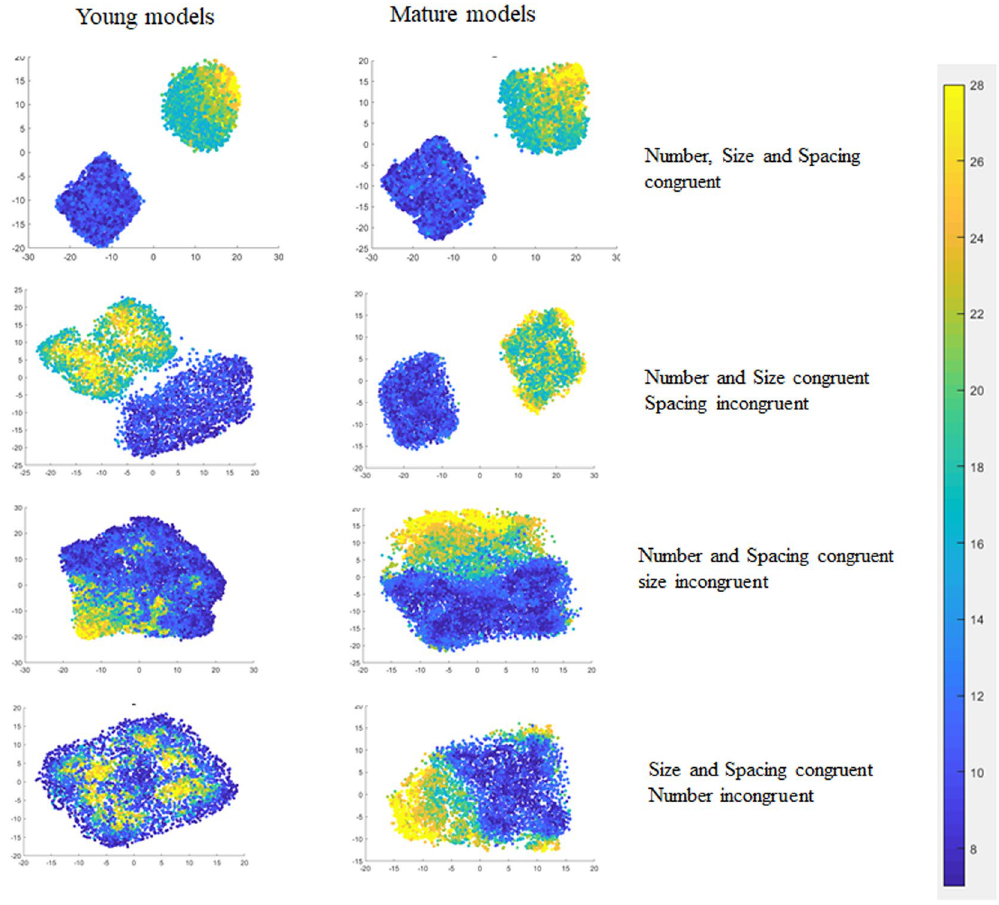
Figure 5. Manifold projection using t-SNE. Stimuli with a small or large numerosity (respectively in the ranges 7:12 and 16:28) were first selected from the complete image data set. In the top panels, Numerosity, Size and Spacing are all congruent, which means that images with a small number of dots also have low Spacing and Size values. In the second-row panels, Numerosity and Size are congruent, but Spacing is not. In the third-row panels, Numerosity and Spacing are congruent, but Size is not. In the bottom panels, both Spacing and Size are incongruent with Numerosity. Results show that in the Mature model the representations are mostly